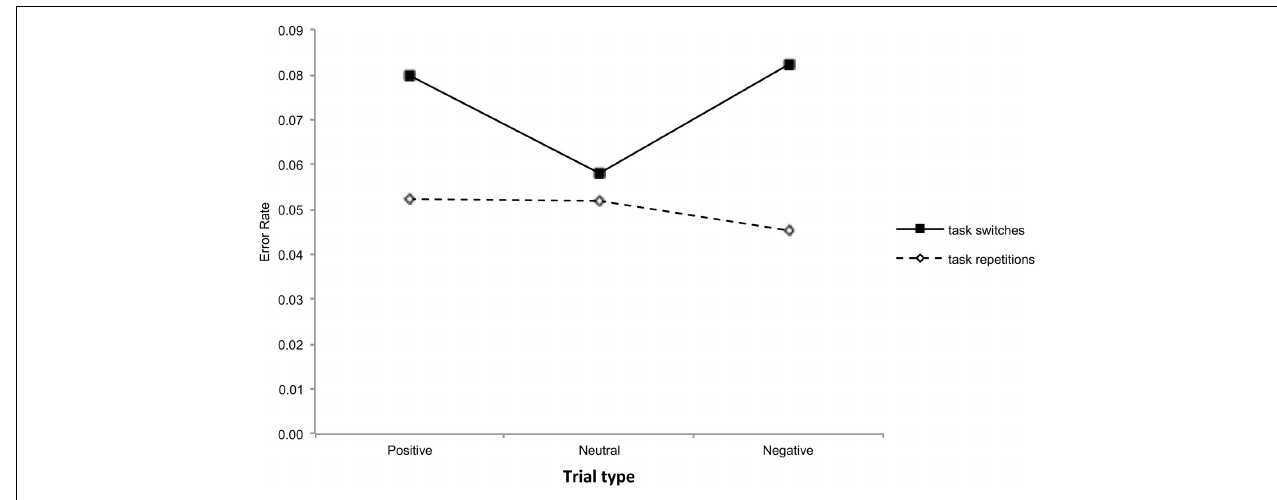
FIGURE 3 | Error rates as a function of task transition and trial type.